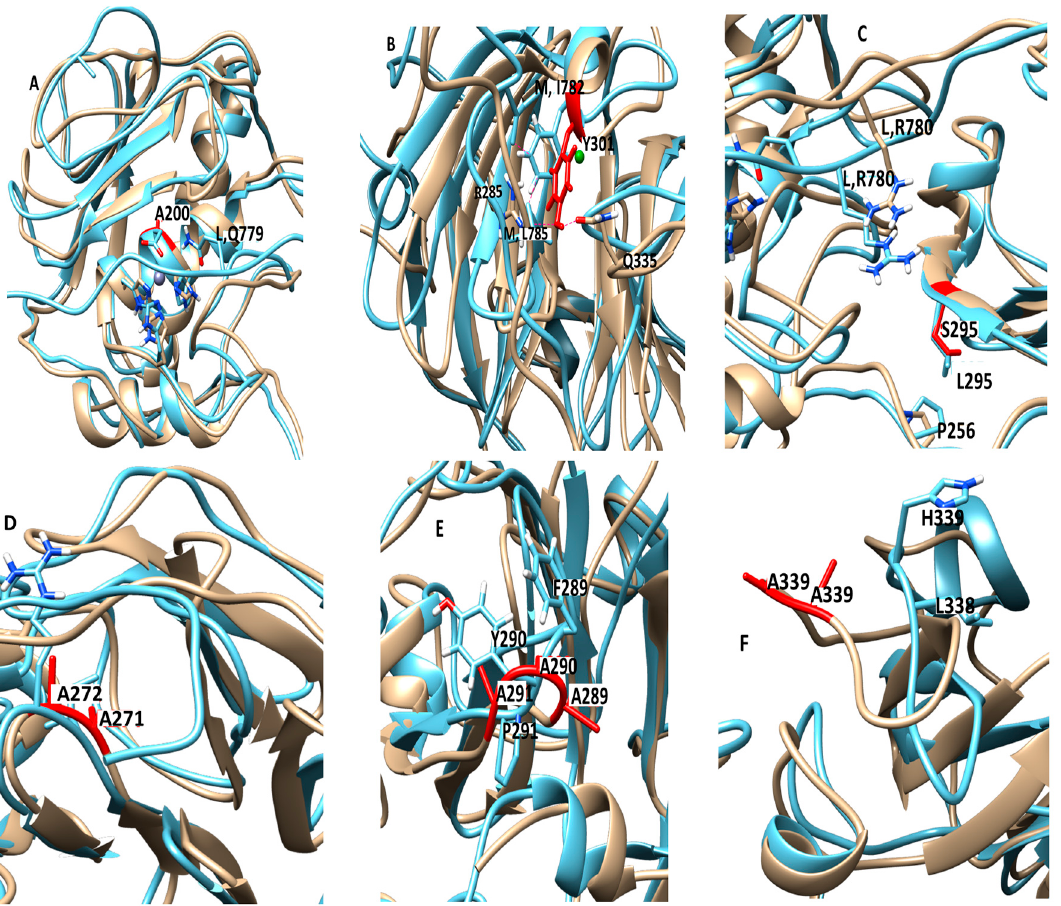
Figure 7. Locations of the mutants in the structure of MMP-1•THP. ( A ) E200A (1.21 Å); ( B ) F301Y (1.24 Å); ( C ) L295S (1.30 Å); ( D ) I271A/R272A (1.3 Å); ( E ) F289A/Y290A/P291A (1.23 Å); and ( F ) L338A/H339A (1.9 Å). The most populated cluster of MMP-1•THP (cyan) is superimposed on the most populated cluster structure from the different mutants (brown) (The RMSD between the mutant structure and the WT MMP-1•THP are indicated in parentheses). Zn 2+ and Ca 2+ are shown in spherical representation in ice blue and green, respectively.